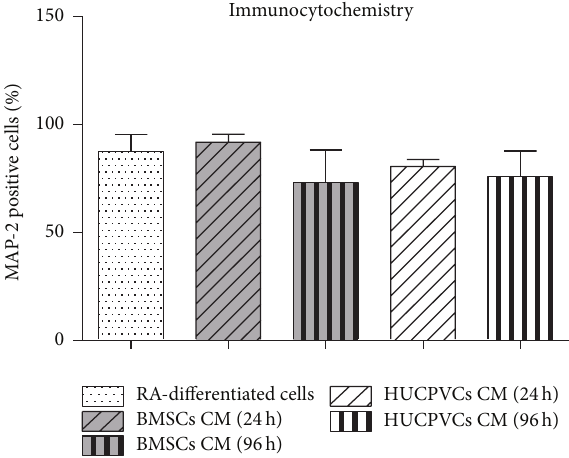
Figure1:Metabolic viability (MTStest)ofSH-SY5Ycells sevendays after incubation with BMSCs and HUCPVCs CM. Results revealed that, for all CM tested conditions, the secretome of both MSCs populations is able to support neuronal-like cell viability without the use of any other exogenous growth factors. The differences observed towards RA-differentiated cells ( 𝑃 < 0.05 ) are considered to be natural as these cultures were supplemented with 1% of FBS. Concerning statistical differences among time points, BMSCs CM 24 h promoted a significant increase in SH-SY5Y cells viability when compared with the HUCPVCs CM 24 h group ( 𝑃 < 0.01 ) (values are shownasmean ± SEM, 𝑛 = 3 ).Symbolscorrespondencetostatistical signification: (1) ∗ refers to comparisons between RA-differentiated cells and MSCs CM; (2) # regards the correlation between MSCs CM from the same time point ( ## 𝑃 < 0.01 , ∗ 𝑃 < 0.05 ).